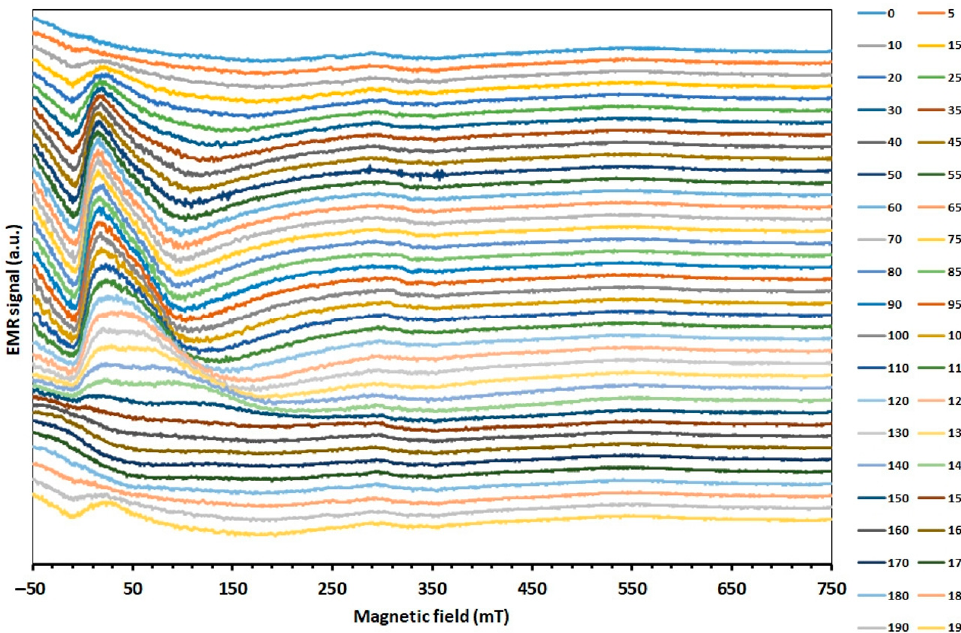
Figure 1. EMR spectra as a function of the angular dependence of Zn 0.8 Co 0.2 O/Ag film.